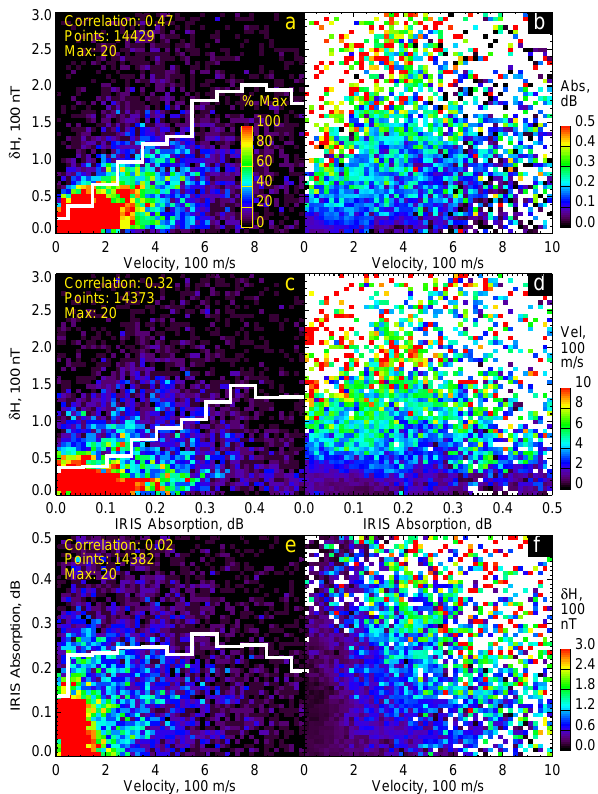
Fig. 2. 2-D plots of (a, b) the IMAGE magnetic perturbation δH versus the EISCAT ion velocity, (c, d) the IMAGE magnetic per- turbation versus the IRIS absorption, and (e, f) the IRIS absorption versus the EISCAT ion velocity for the entire dataset. In panels (a), (c) and (e) the occurrence of points for each cell up to a maximum of 20 is shown, colour-coded in percentage of maximum as indicated by the colour bar in panel (a). In panels (b), (d) and (f), the cells are colour-coded in the mean absorption, velocity, and perturbation, respectively, as shown on the right of each panel. The correlation for the entire dataset is shown in the top-left corner of panels (a), (c), and (e) along with the total number of points. The bin-averaged parameter dependence is shown by the white histogram.